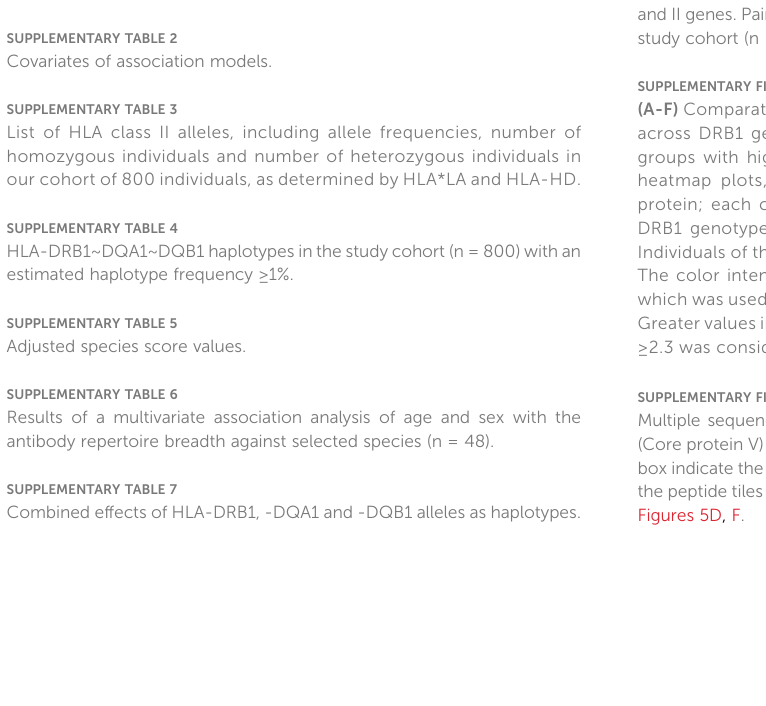
SUPPLEMENTARY TABLE 1 HLA genotypes for each study subject inferred by using HLA*LA and HLA-HD.